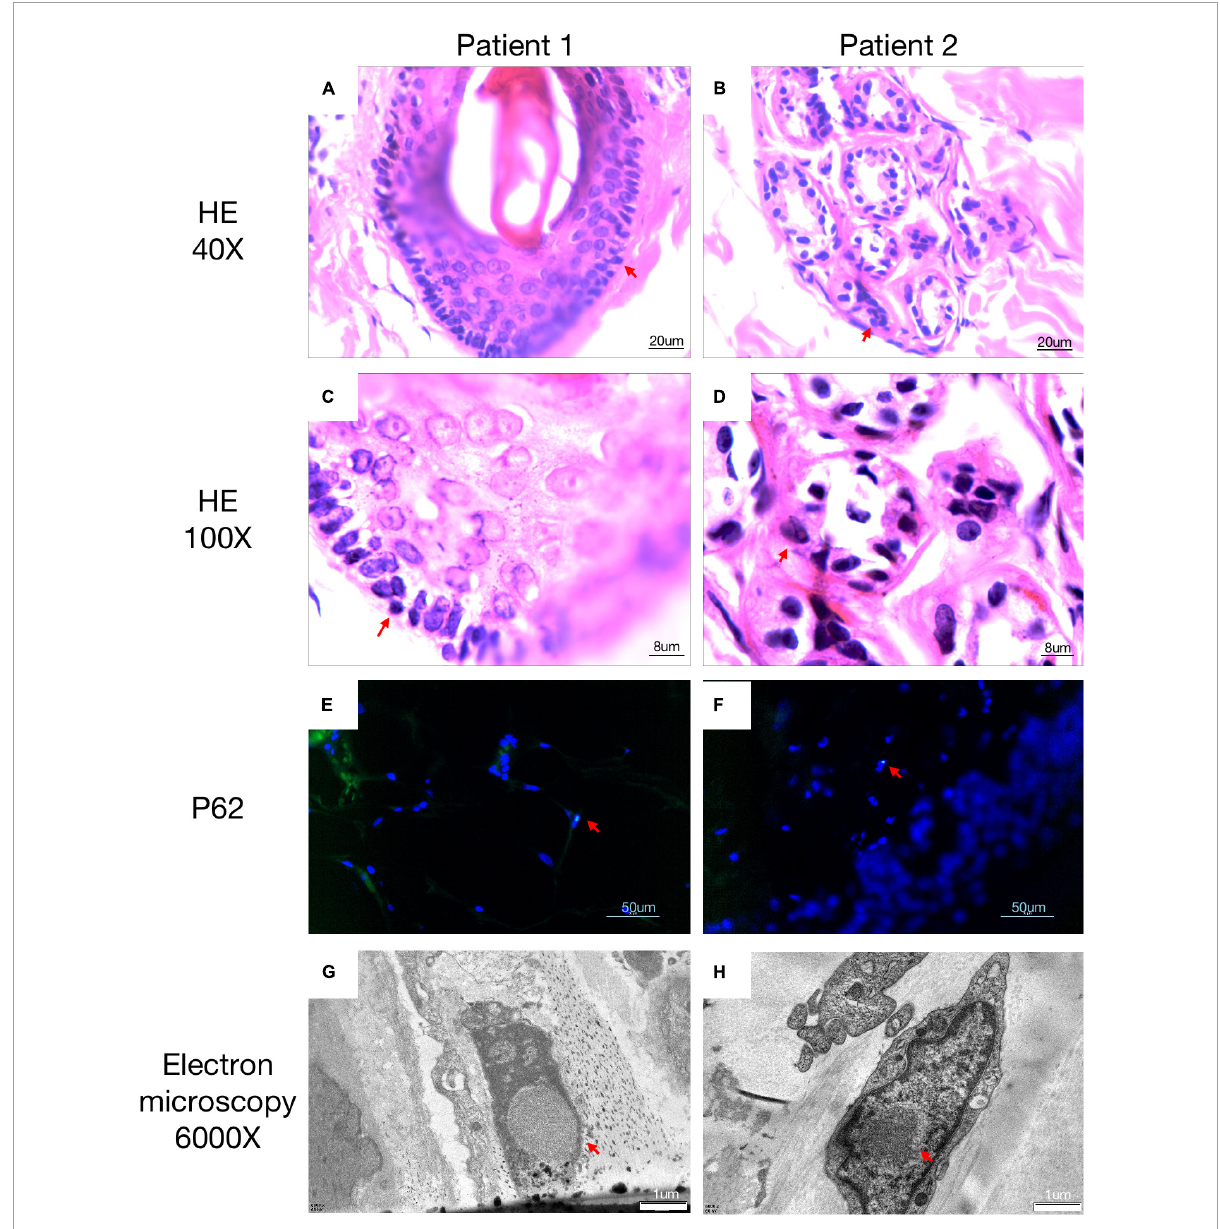
FIGURE3 Histopathological findings of NIID. H&E staining of skin biopsy shows the presence of eosinophilic intranuclear inclusion bodies (A–D) . Intranuclear inclusions stained with anti-p62 antibody were observed in the 4 (cid:48) ,6-diamidino-2-phenylindole di-lactate –positive nuclei by double immunofluorescence staining (E,F) . Electron microscopy showed intranuclear inclusions as a pile of round filament material without a limiting membrane (G,H) . All positive pathology results were concluded by comparison with a healthy population.